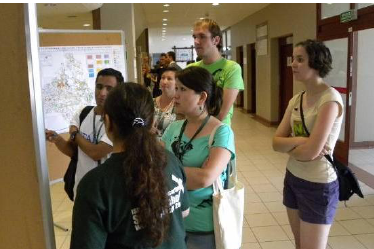
Figure 12. Poster Session during the 1 st ISPRS SC